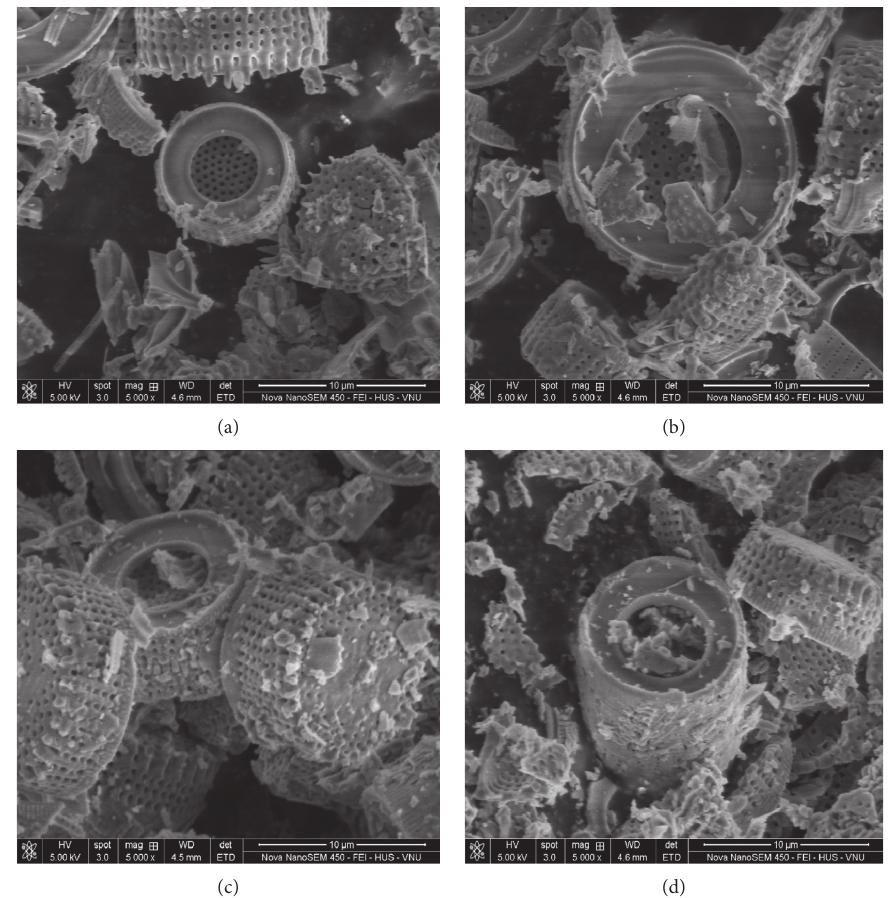
Figure 4: SEM images of (a) diatomite, (b) 1CuCl/diatomite, (c) 2CuCl/diatomite, and (d) 3CuCl/diatomite.